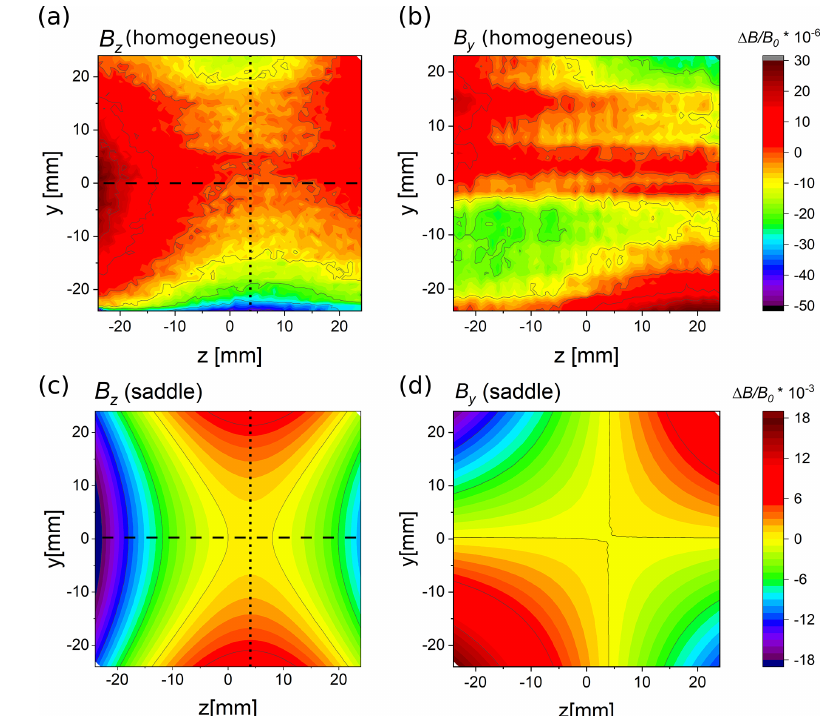
Figure 3. Measurements of the flux densities along the z axis. Data for homogeneous field distribution relative to the coil center in parts per million are shown in (a) and (b) . The same values for the saddle field configuration are exhibited in (c, d) . The axial components for B z are shown in (a) and (c) , whereas (b) and (d) display the radial contribution B y . Dashed and dotted lines correspond to Fig. 4.